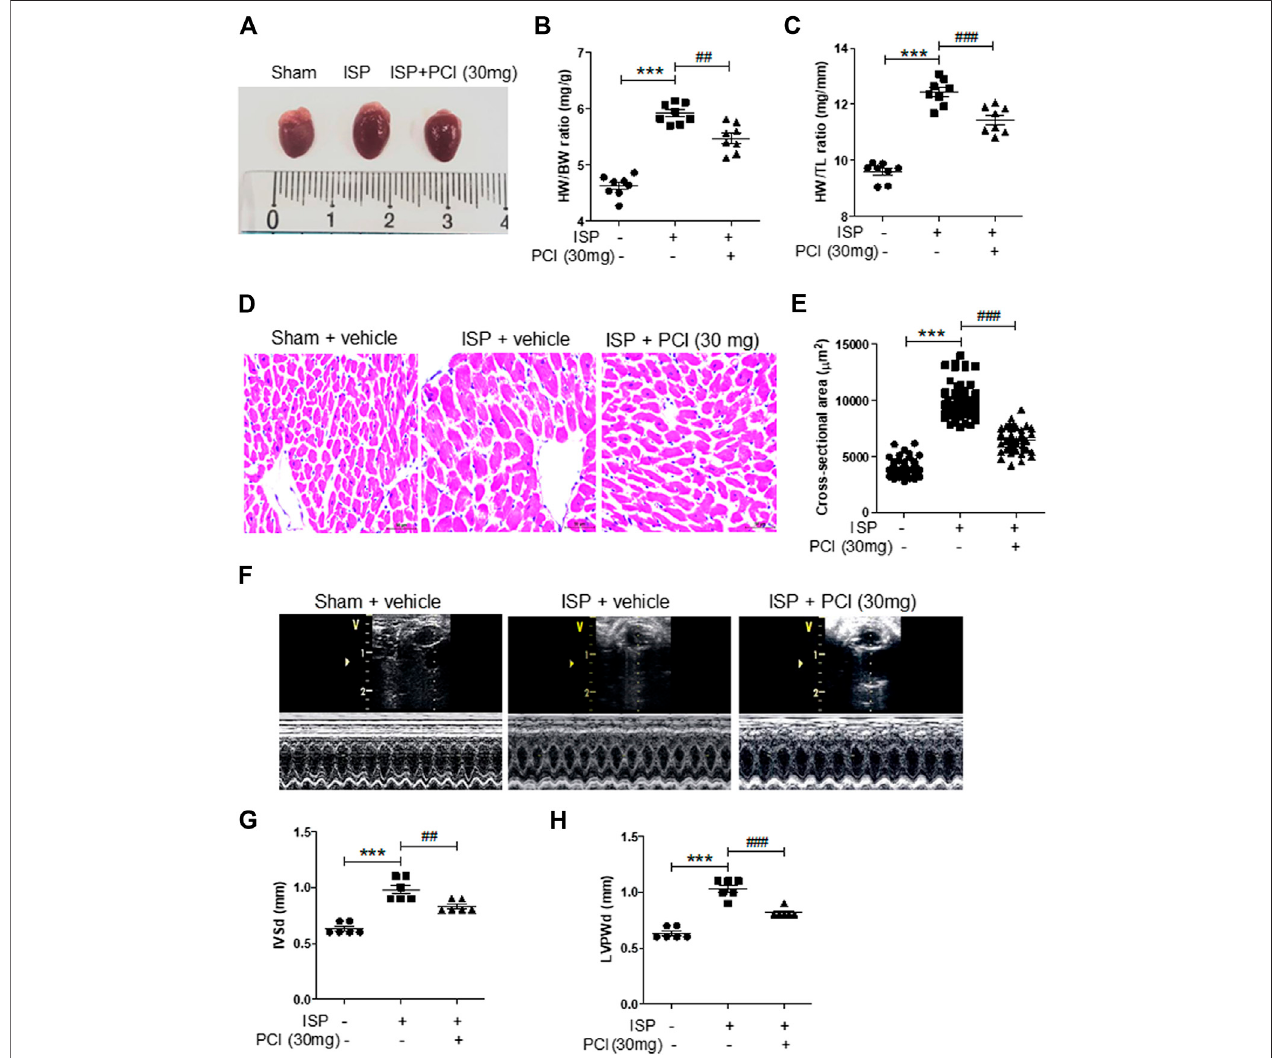
FIGURE 1 | HDAC8 selective inhibitor reduces isoproterenol-induced cardiac hypertrophy in mice (A) Representative images of hearts from sham, isoproterenol (ISP), and ISP + PCI34051 (30 mg/kg/day) mice treated for 5 days (B) Heart weight to body weight (HW/BW) ratios ( n (cid:2) 8). *** p < 0.001; ## p < 0.01 (C) Heart weight to tibia length (HW/TL) ratios ( n (cid:2) 8). *** p < 0.001; ### p < 0.001 (D) H&E staining, representative images of heart tissues from sham, ISP, and ISP + PCI34051 (30 mg/kg/ day) mice treated for 5 days ( n (cid:2) 8). Scale bar (cid:2) 50 μ m (E) Quanti fi cation of cardiomyocyte size cross-sectional area of samples described in (D) . *** p <